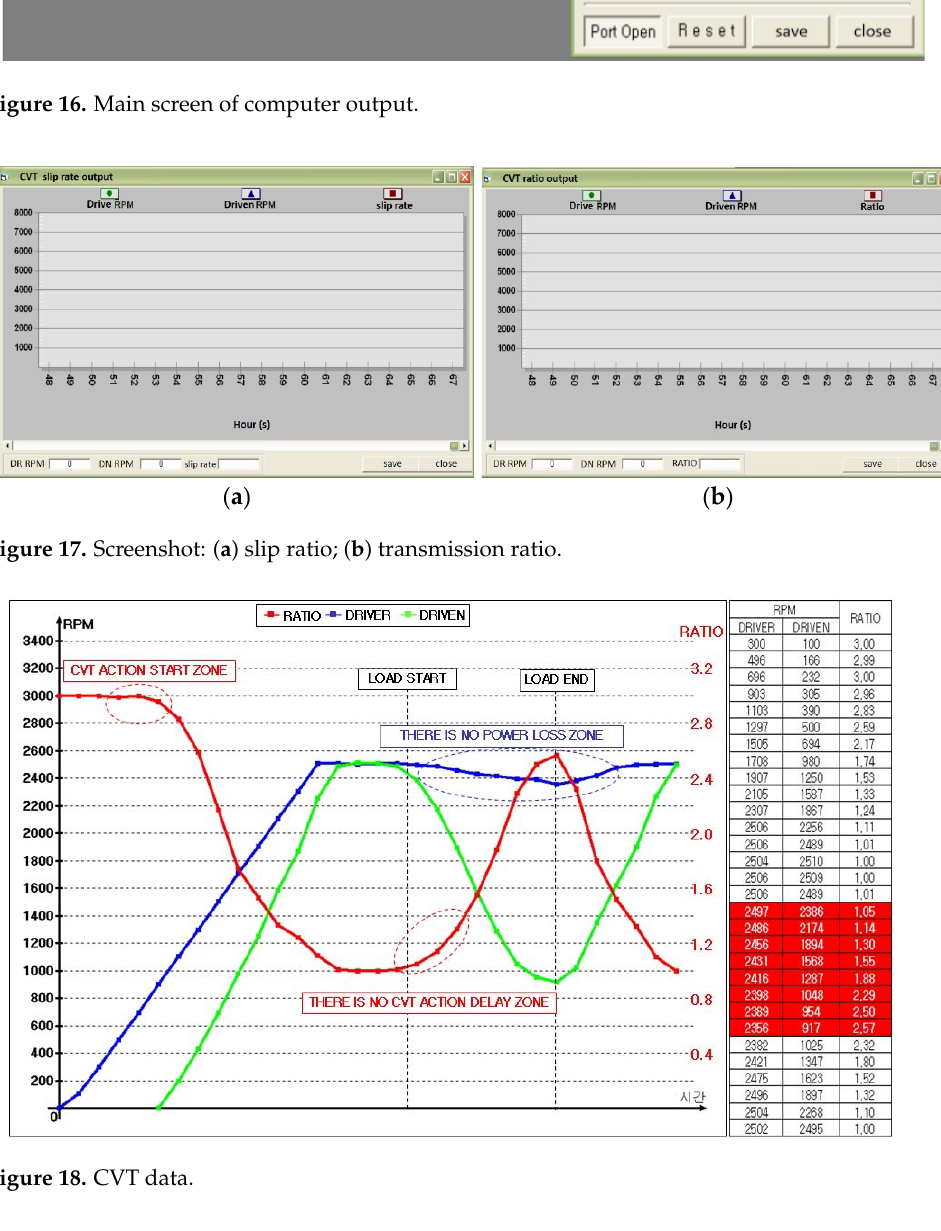
Figure 19. Driving tester concept. The vehicle was equipped with a servomotor to control the accelerator. Additionally, a large roller that transmits rotation and load to the rear wheels, a power brake that deliv- ers a load similar to that experienced when driving uphill, and a vibrator that simulates a road surface in poor conditions were configured to test durability. The vehicle was tied with a rope to prevent it from slipping off the rollers during testing. As shown in Figure 20, a driving test and durability test were conducted, in which a centrifugal belt pulley was installed in a 4 kW electric vehicle with a CVT.